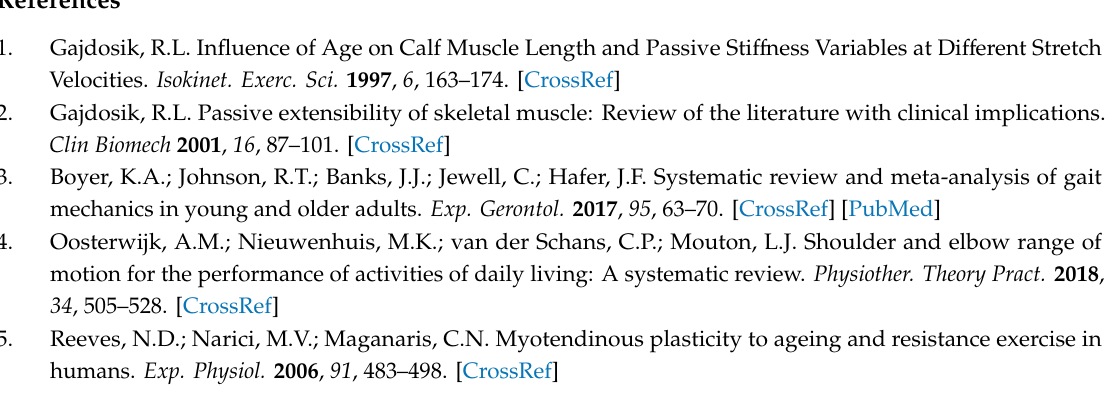
Figure S1 . Individual data obtained after interpolation of experimental data from each tensile test on fibers and bundles; Table S1 A) subjects (all males) who volunteered for the biopsy